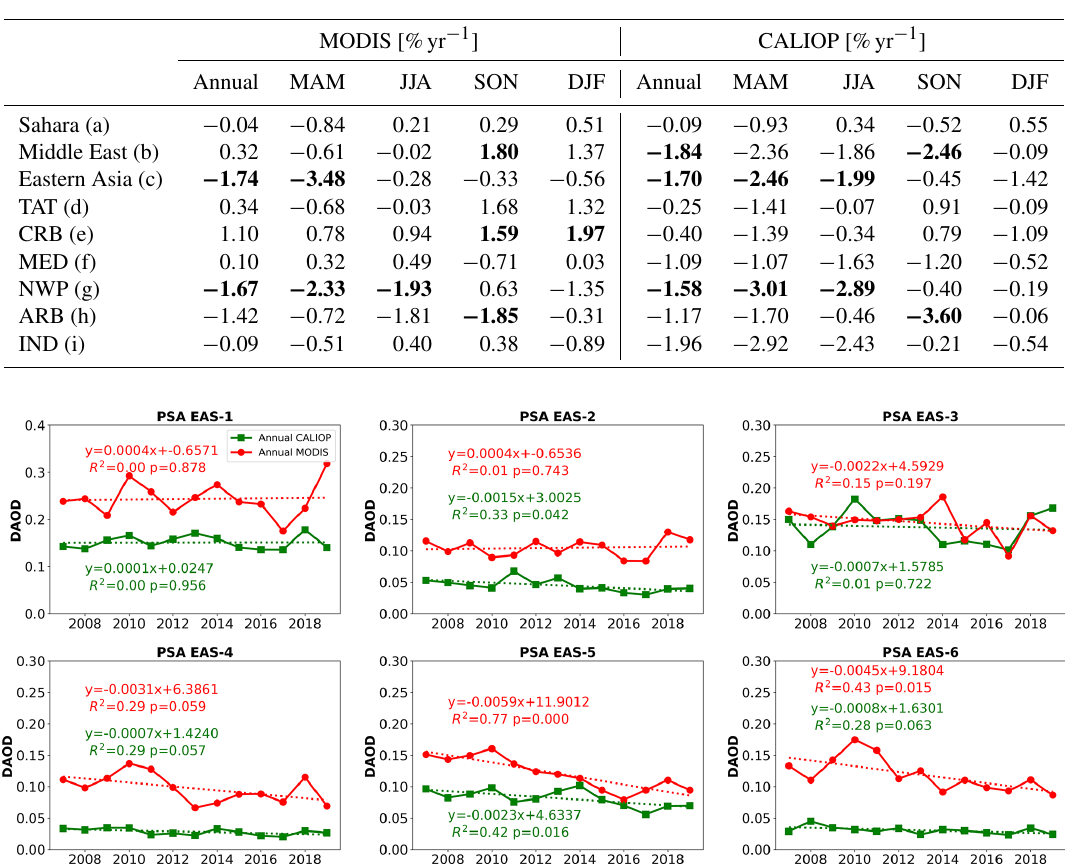
Table 5. DAOD trend over major dust-laden regions based on MODIS and CALIOP observations. The changing rate of DAOD trend is shown in a sequence of annual/spring/summer/fall/winter in each cell of the table. Those statistically meaningful trends with p < 0 . 05 are shown in bold.